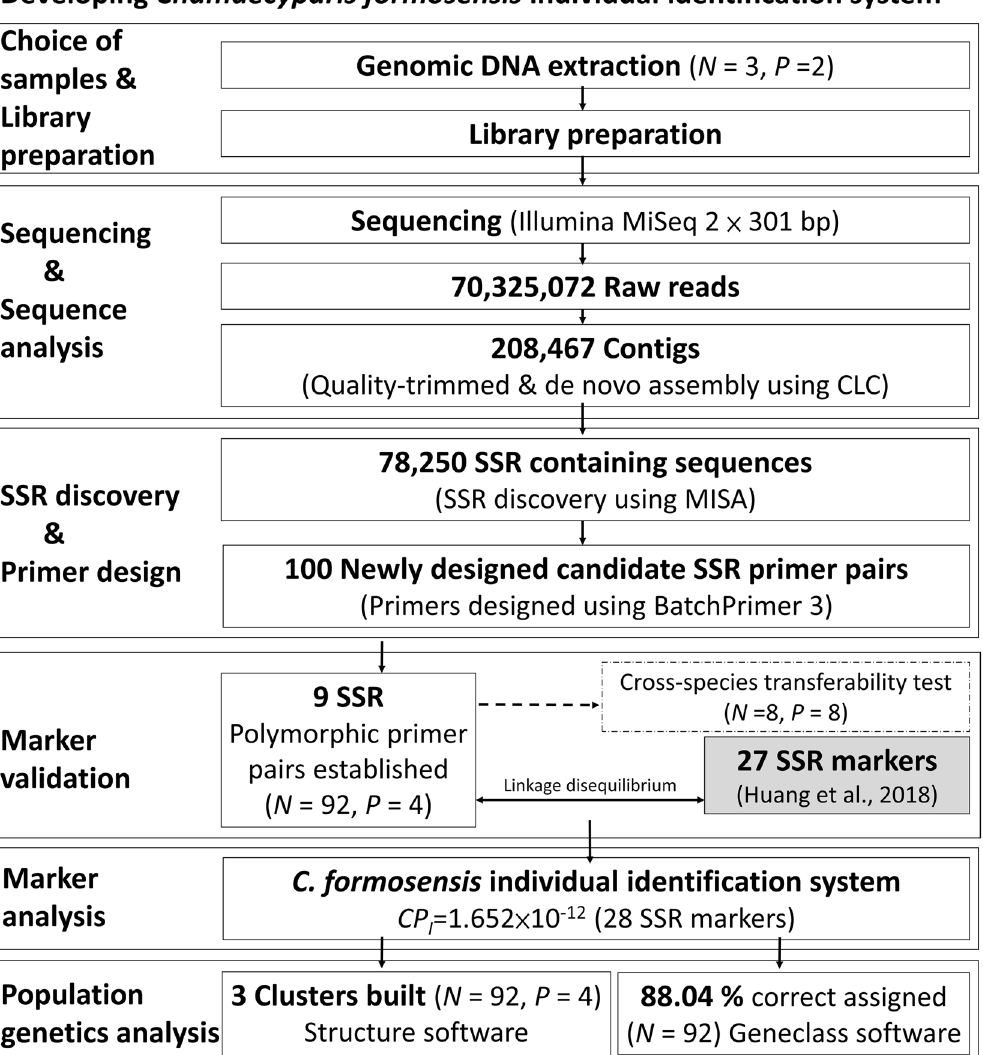
Figure 1. Flowchart of Chamaecyparis formosensis individual identification system development. N : the number of individuals; P : the number of populations; MISA : Mi cro SA tellite software; CP I : combined probability of